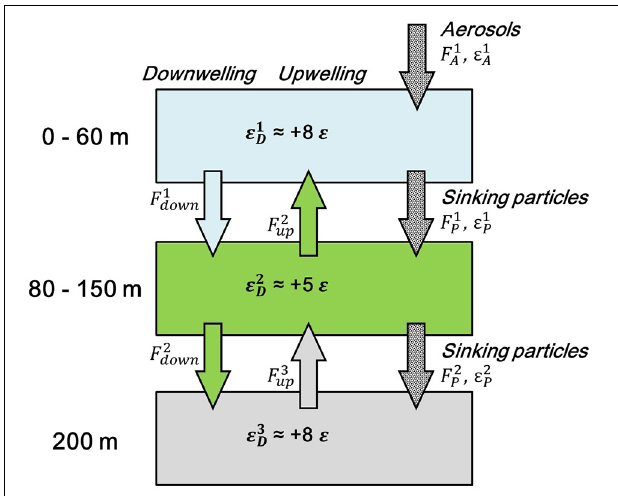
FIGURE 7 | Box model for the cycling of Cd in the euphotic zone of the West Philippine Sea. The arrows with dotted pattern stand for particle fluxes (aerosols and sinking particles), the arrows in green stand for the output fluxes from the 80 to 150m box from vertical advection, the arrow in light blue stands for the output flux from the 0 to 60m box from downward advection, and the gray arrow stands for the output flux from the 200m water mass from bottom-up advection. F, Cd fluxes; ε , Cd isotopic composition in the boxes or of the fluxes. The averaged Cd isotopic composition in the 0–60m, 80–150m, and the composition at 200m in the WPS, + 8, + 5, and + 8 ε , respectively, are applied to the